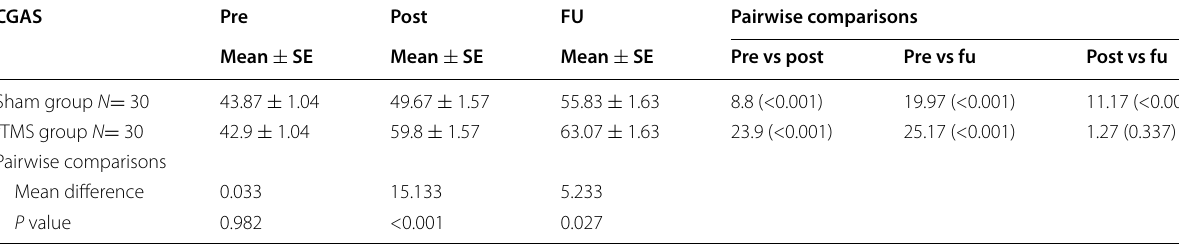
Table 6 Comparing mean Children Global Assessment score between the 2 groups at different times CGAS Pre Post